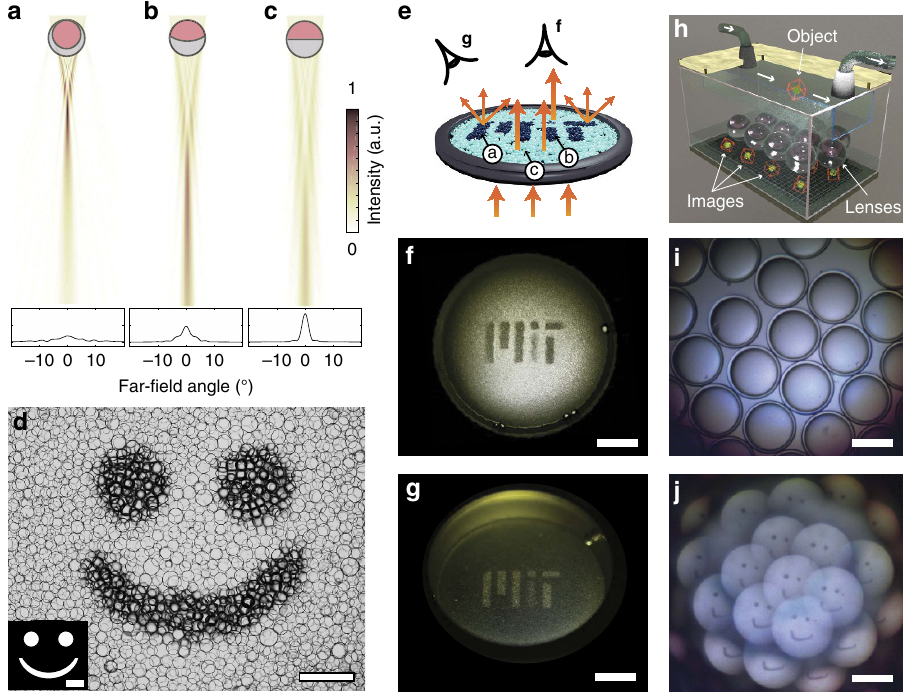
Figure 4 | Towards potential applications. ( a – c ) 2D finite difference time domain simulations of droplets of 5 m m radius for incident light of 500nm wavelength. The internal radii of curvature are 4 m m ( a ), 9 m m ( b ) and infinite ( c ). ( d ) Localized exposure of light-sensitive surfactants to UV light leads to a local variation in droplet morphology and scattering behaviour, which is used to create an image. The dark zones in the image represent particles that have switched to the double emulsion state ( a ). They scatter light more strongly and therefore appear darker than the flat interface Janus droplets ( b ). The inset shows the photomask. Scale bars ¼ 500 m m. ( e ) Schematic showing two different geometries for observing the photo-patterned droplet films, corresponding to the perceived images shown in f , g . The labels a, b and c correspond to the droplet geometries shown in panels a – c . ( f , g ) Photo-patterned droplets viewed from above ( f ) and at an angle ( g ). Scale bars ¼ 5mm ( f , g ). ( h ) Concept sketch for tomographic imaging of micro-scale objects in a microfluidic system using the fluid compound lenses. Each lens captures an image of the object (here a red cube with yellow sphere) at a different perspective. We anticipate that the three-dimensional shape of imaged objects can be reconstructed from the elemental images. ( i ) Monolayer array of fluid compound lenses. ( j ) Images projected by the monolayer lenses. ( i , j ) Scale bars ¼ 100 m